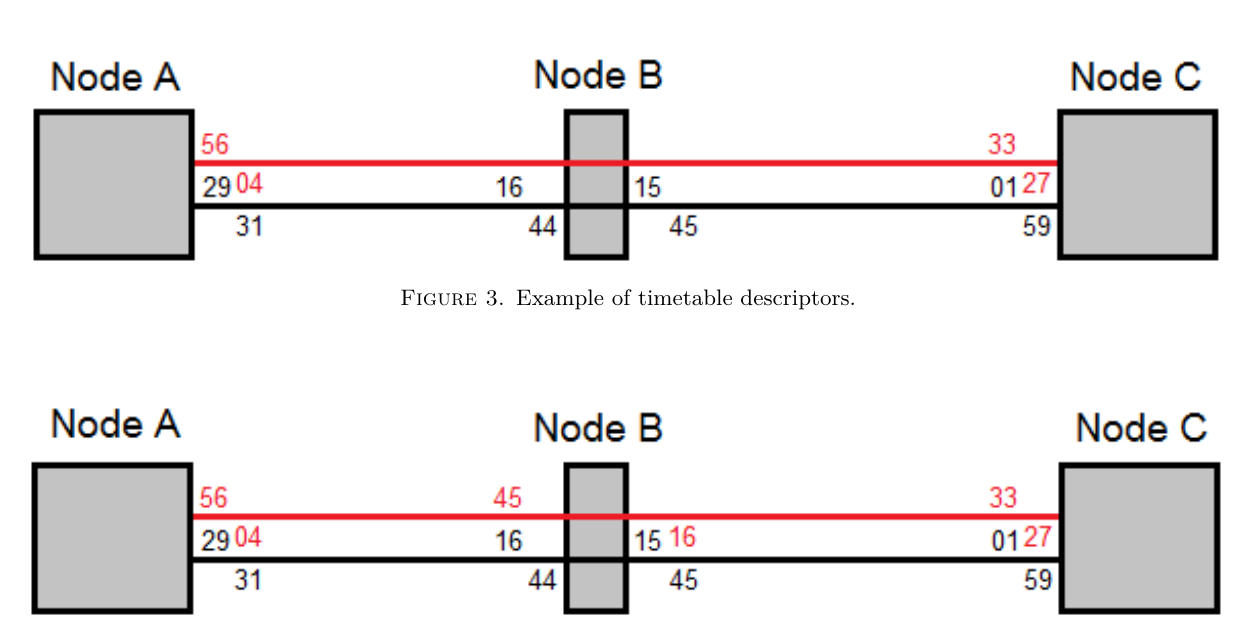
Figure 4. Extended timetable descriptors example. Serviced nodes are distinguished with dots of respective colour of the line.